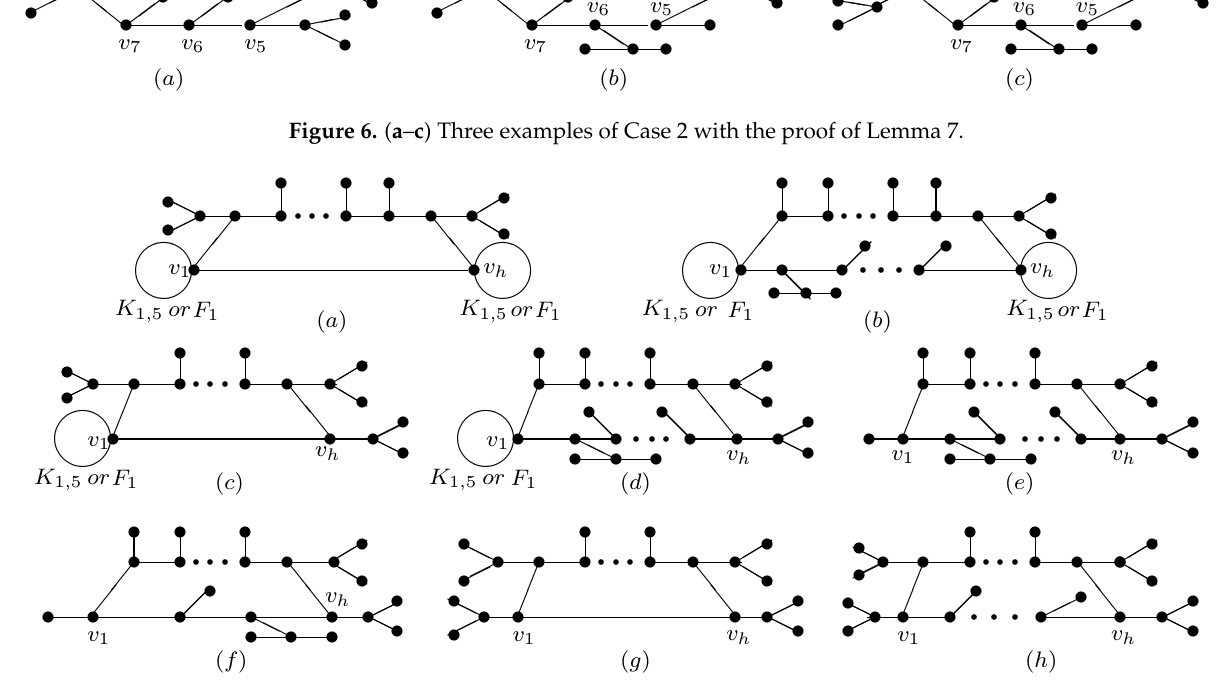
Figure 7. ( a – h ) Seven typical examples on G of Case 3 with the proof of Lemma 3.3